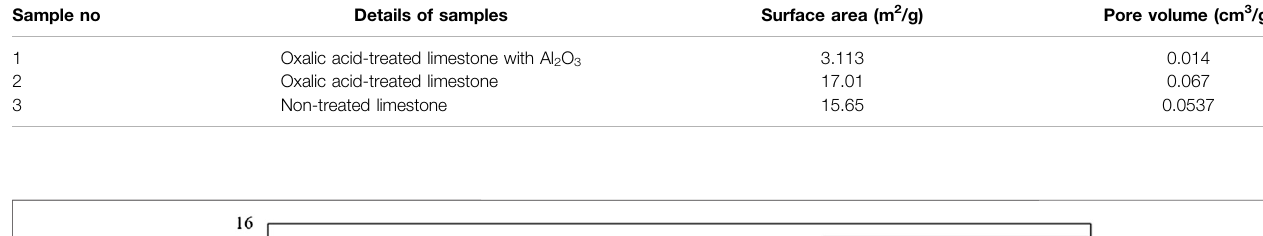
Frontiers in Energy Research |